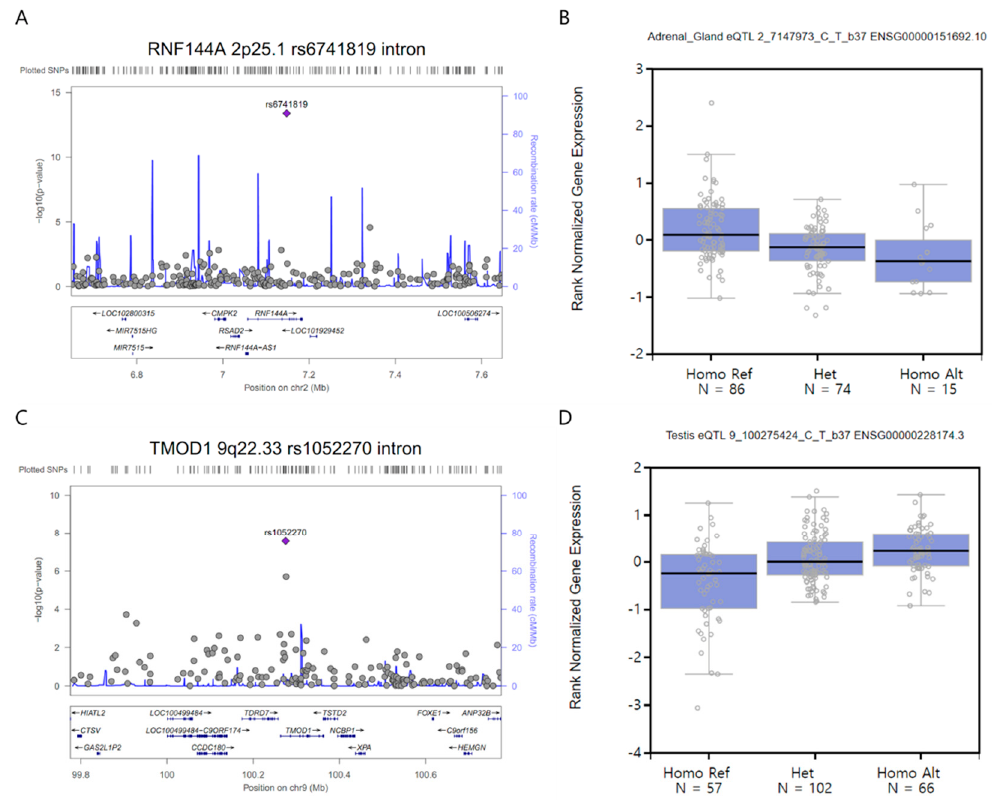
Figure 3. ( A and C ) A regional plot of ( A ) the rs6741819 (intron, RNF144A , 2p25.1) and ( C ) rs1052270 (intron, TMOD1 , 9q22.33) variants ( ± 500 kb) demonstrates associations with intracranial aneurysms in 250 patients and 294 controls after adjusting for age, sex, hypertension, diabetes, hyperlipidemia, cigarette smoking, and four principal components. The x- and y-axes indicate the chromosomal position (mega base, Mb) and -log 10 transformed P -values, respectively. The purple diamonds indicate the rs6741819 and rs1052270 variants with genome-wide associations in our study ( p = 4.0 × 10 − 14 and 2.7 × 10 − 8 , respectively). The gray circles indicate other SNPs within 500kb of the rs6990241 and rs1052270 variants’ position. ( B and D ) The expression level of ( B ) rs6741819 and ( D ) rs1052270 variants in the adrenal gland ( n = 175) and testis ( n = 225) tissues, respectively, according to single-cell expression quantitative trait loci (eQTL) in the GTeX portal (https://gtexportal.org/home). The x- and y-axes indicate three genotypes for each variant and the rank-normalized gene expression level, respectively. The Reference (Ref) and Alternative (Alt) alleles of each variant’s genotypes are equal to their major/minor alleles, respectively. Homo, homozygote; Het, heterozygote.